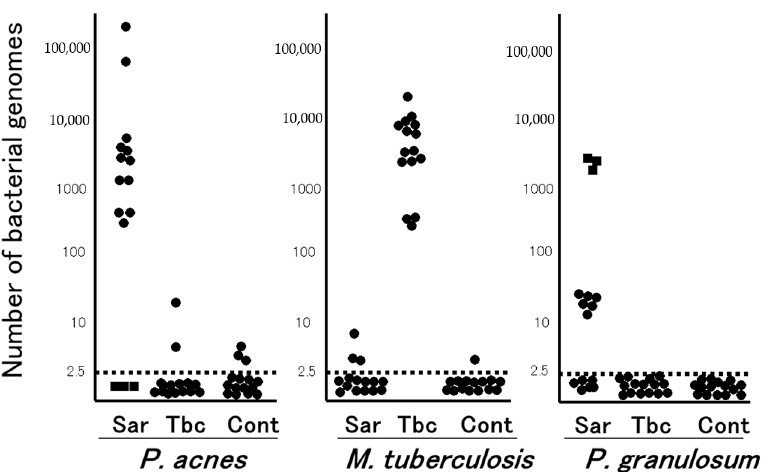
Figure 1. Quantitative PCR for mycobacterial and propionibacterial DNA in sarcoid lymph nodes. Lymph node samples from each of the 15 patients with sarcoidosis (Sar), tuberculosis (Tbc), and gastric cancer (Cont) were used in this study. The horizontal dotted lines show the detection threshold and samples with results below this line are considered negative. Samples without P. acnes detected (as indicated by dotted squares) all contained many P. granulosum (reproduced from Ishige et al. [15] with permission from the publisher).